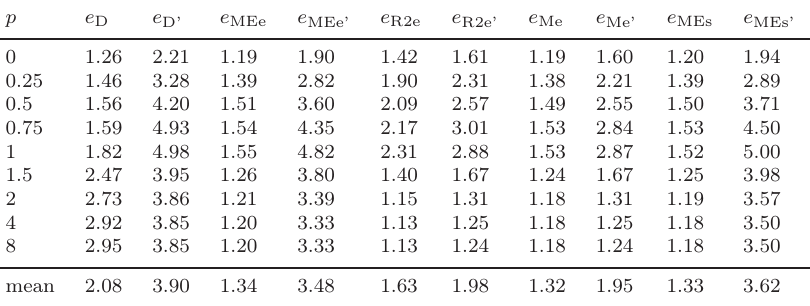
Table 1. Means of error ratios.